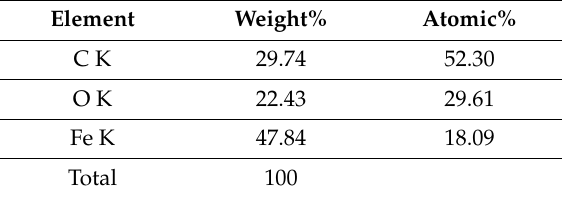
Table 2. EDAX data of Fe 3 O 4 /POA